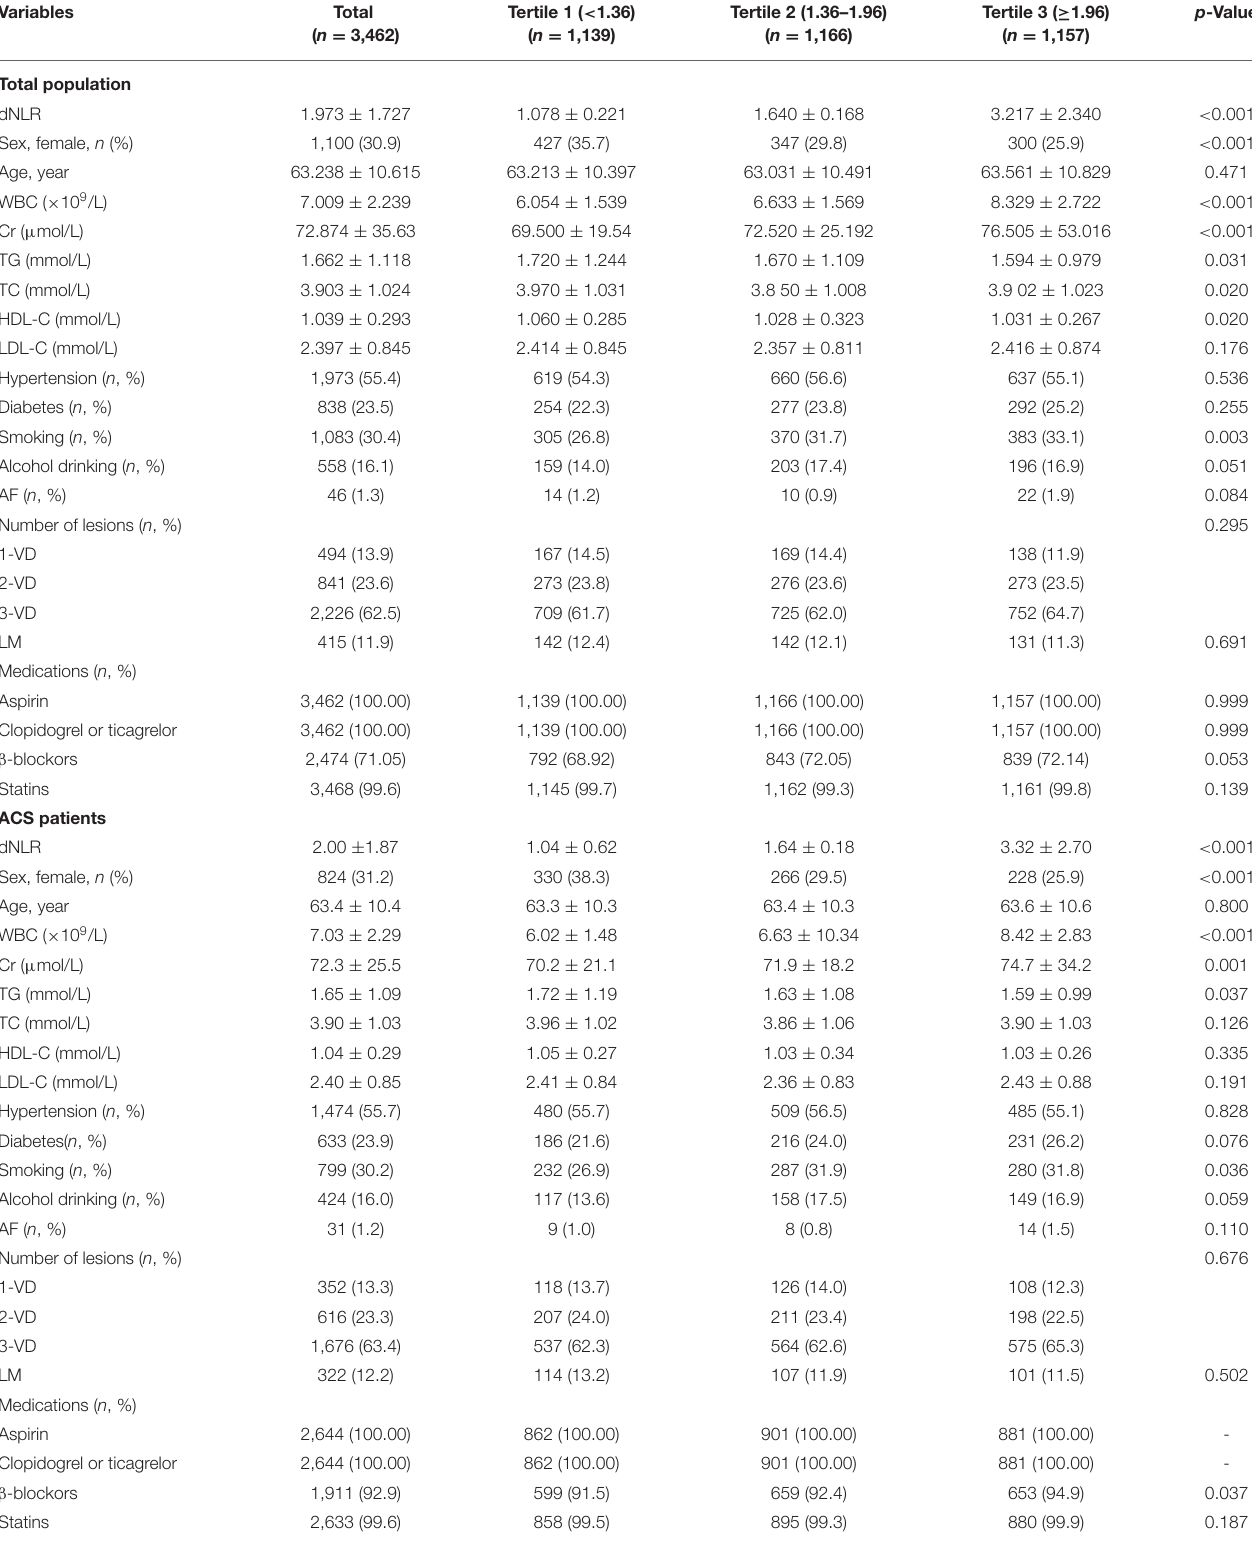
TABLE 1 | Characteristics of participants of the three groups.